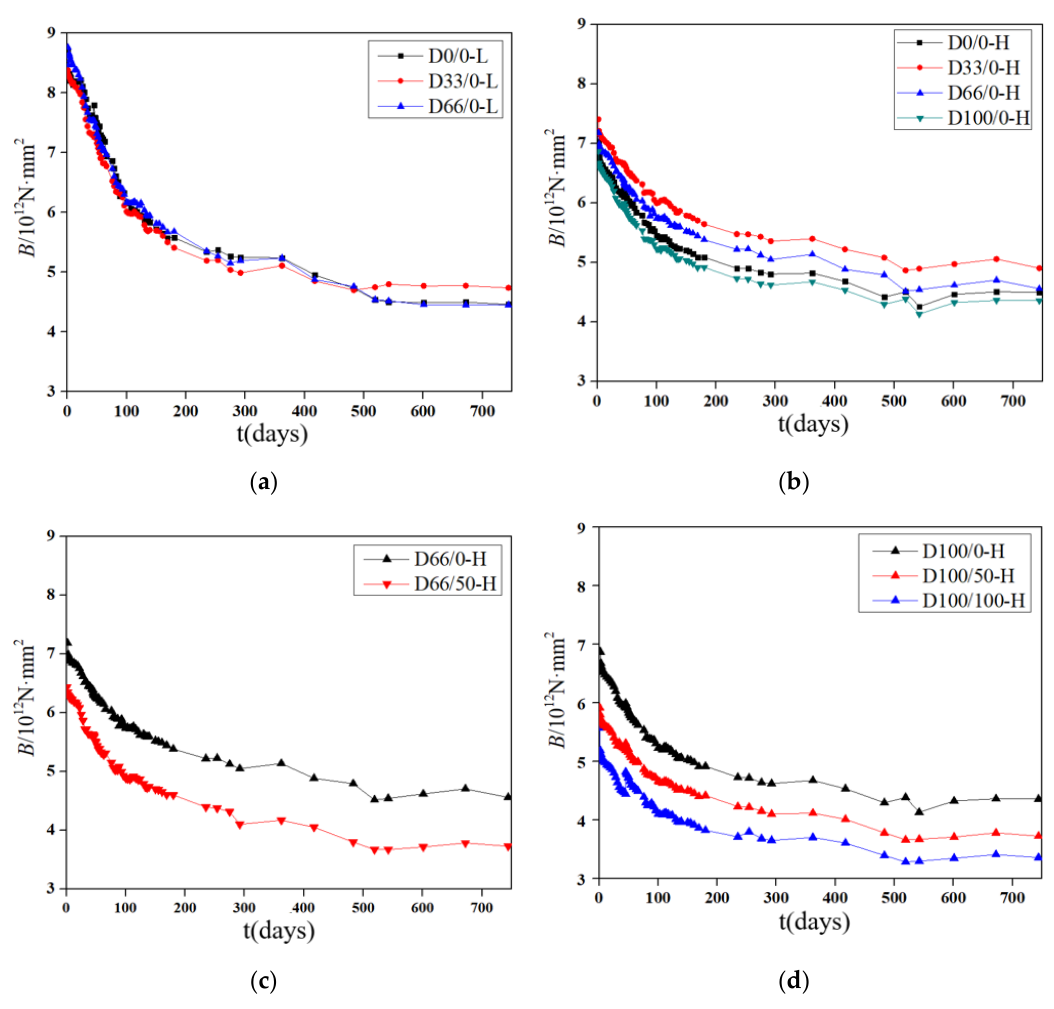
Figure 14. Curves of the midspan stiffness with the load holding time. ( a ) Specimens with RCAs under a low stress ratio; ( b ) specimens with RCAs under a high stress ratio; ( c ) specimens with a 66% RCA replacement rate; ( d ) specimens with a 100% RCA replacement rate.